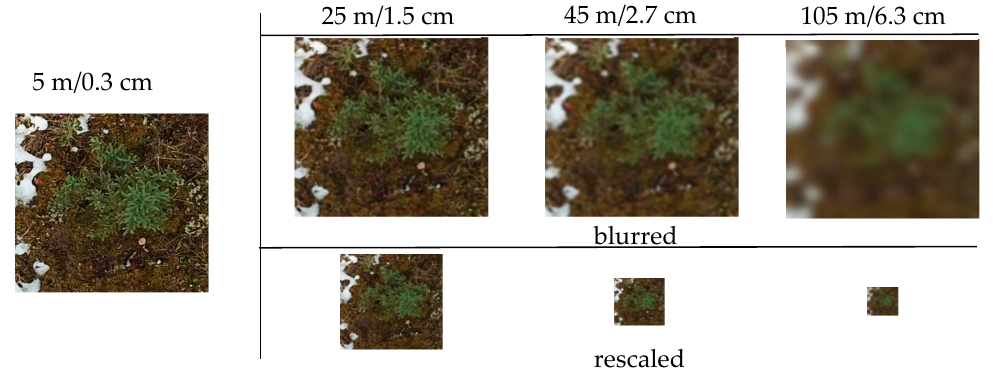
Figure 2. Comparison of images at several emulated flying altitudes. The upper row shows the result of the employed blurring process whereas the lower row additionally shows the size the image would have on an image taken at the corresponding altitude.